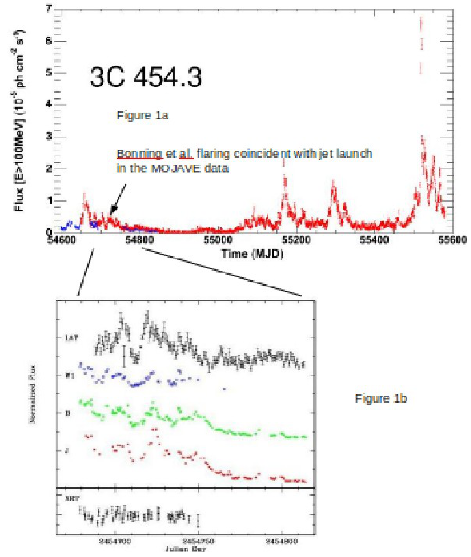
Figure 1: Fermi LAT data (see, e.g., Lott et al. 2013) showing the time history of the flaring from 3C454.3 (Figure 1b), along with the Bonning et al. (2009) data showing concurrent gamma-ray, IR, optical, and UV data (Figure 1b). The time of the jet launch from